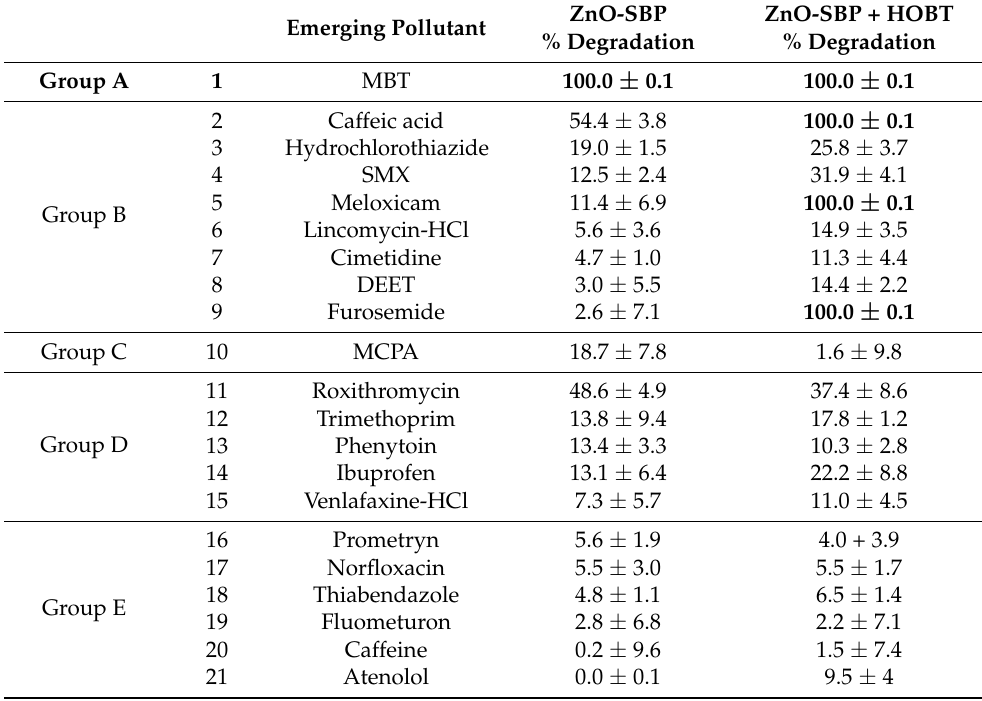
Table 3. Degradation of 21 Eps by ZnO-SBP ±